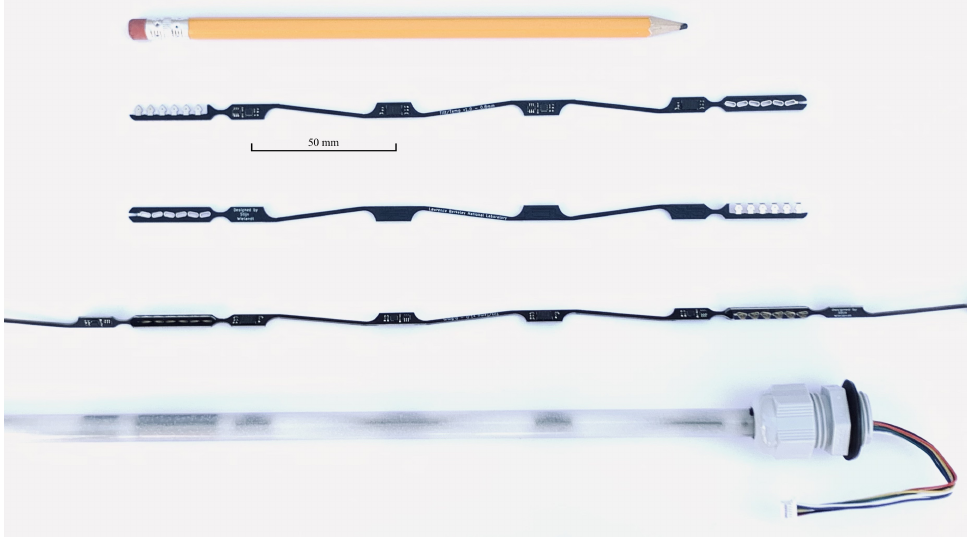
Figure 4. Modular design of the sensor probe. From top to bottom: top view of a sensor board, bottom view of a sensor board, cascaded sensor boards, and final probe assembly containing an array of cascaded sensor sections in a 3/8 in. ( ∼ 10 mm) outer diameter tube, filled with